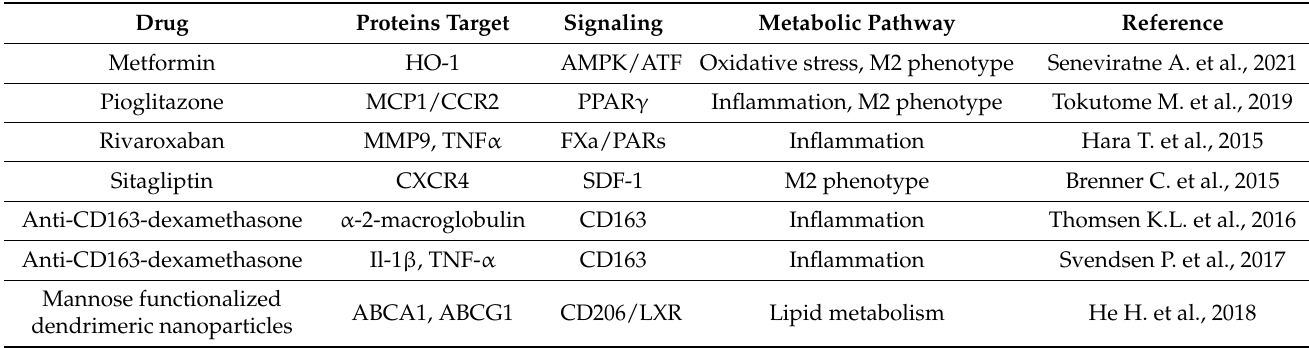
Table 2. Summary of macrophage proteins modulated by